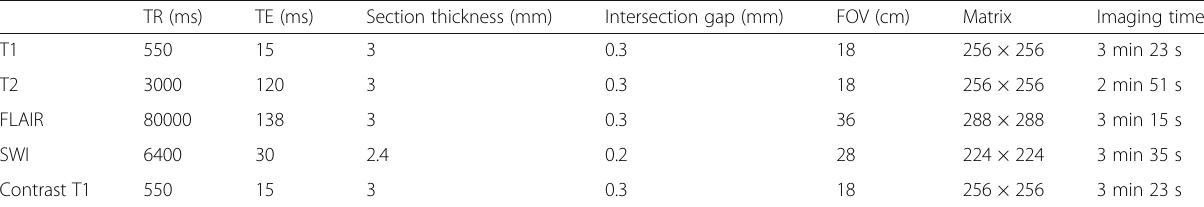
Table 1 MR imaging